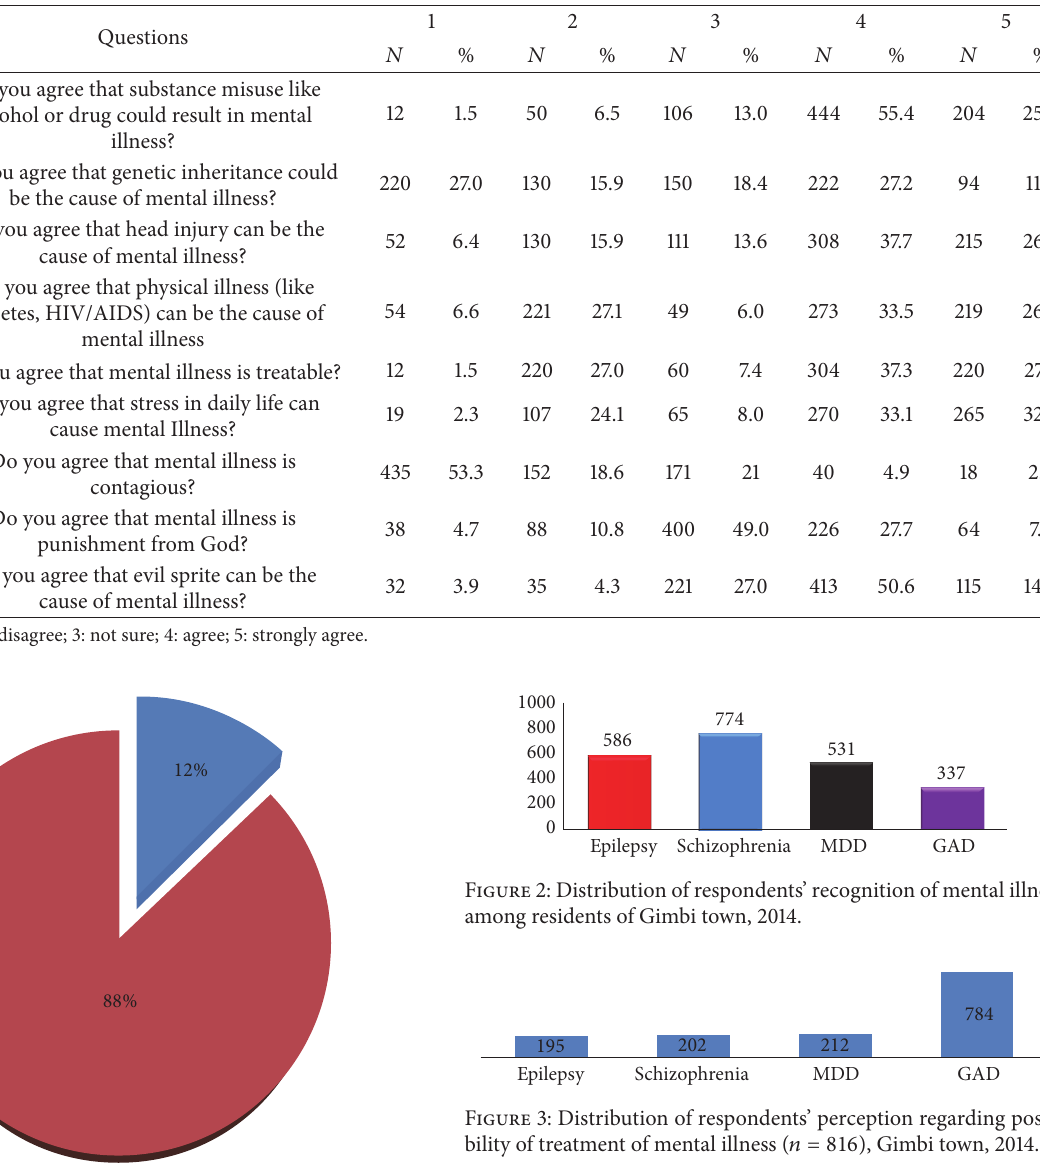
Table 2: Distribution of community’s perception of mental illness among the residents of Gimbi town, Oromia region, Ethiopia ( 𝑛 = 816 ), 2014.